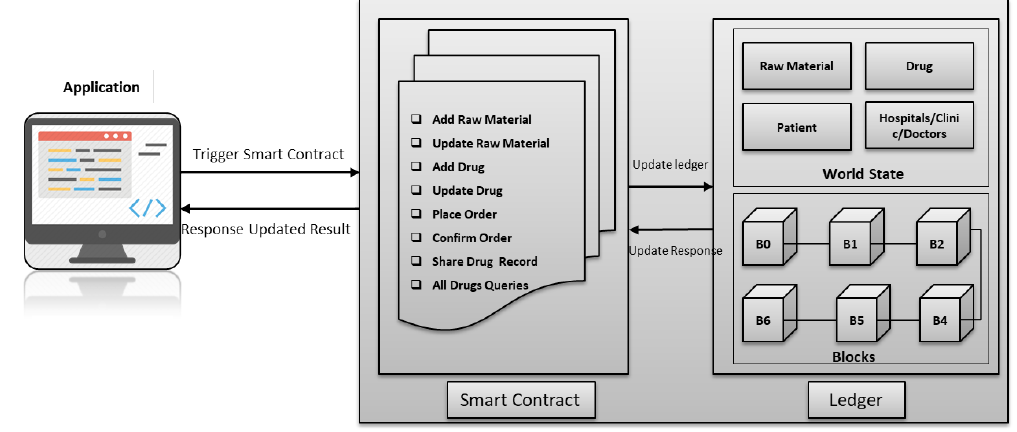
Figure 3. Smart contract execution in DSCMR